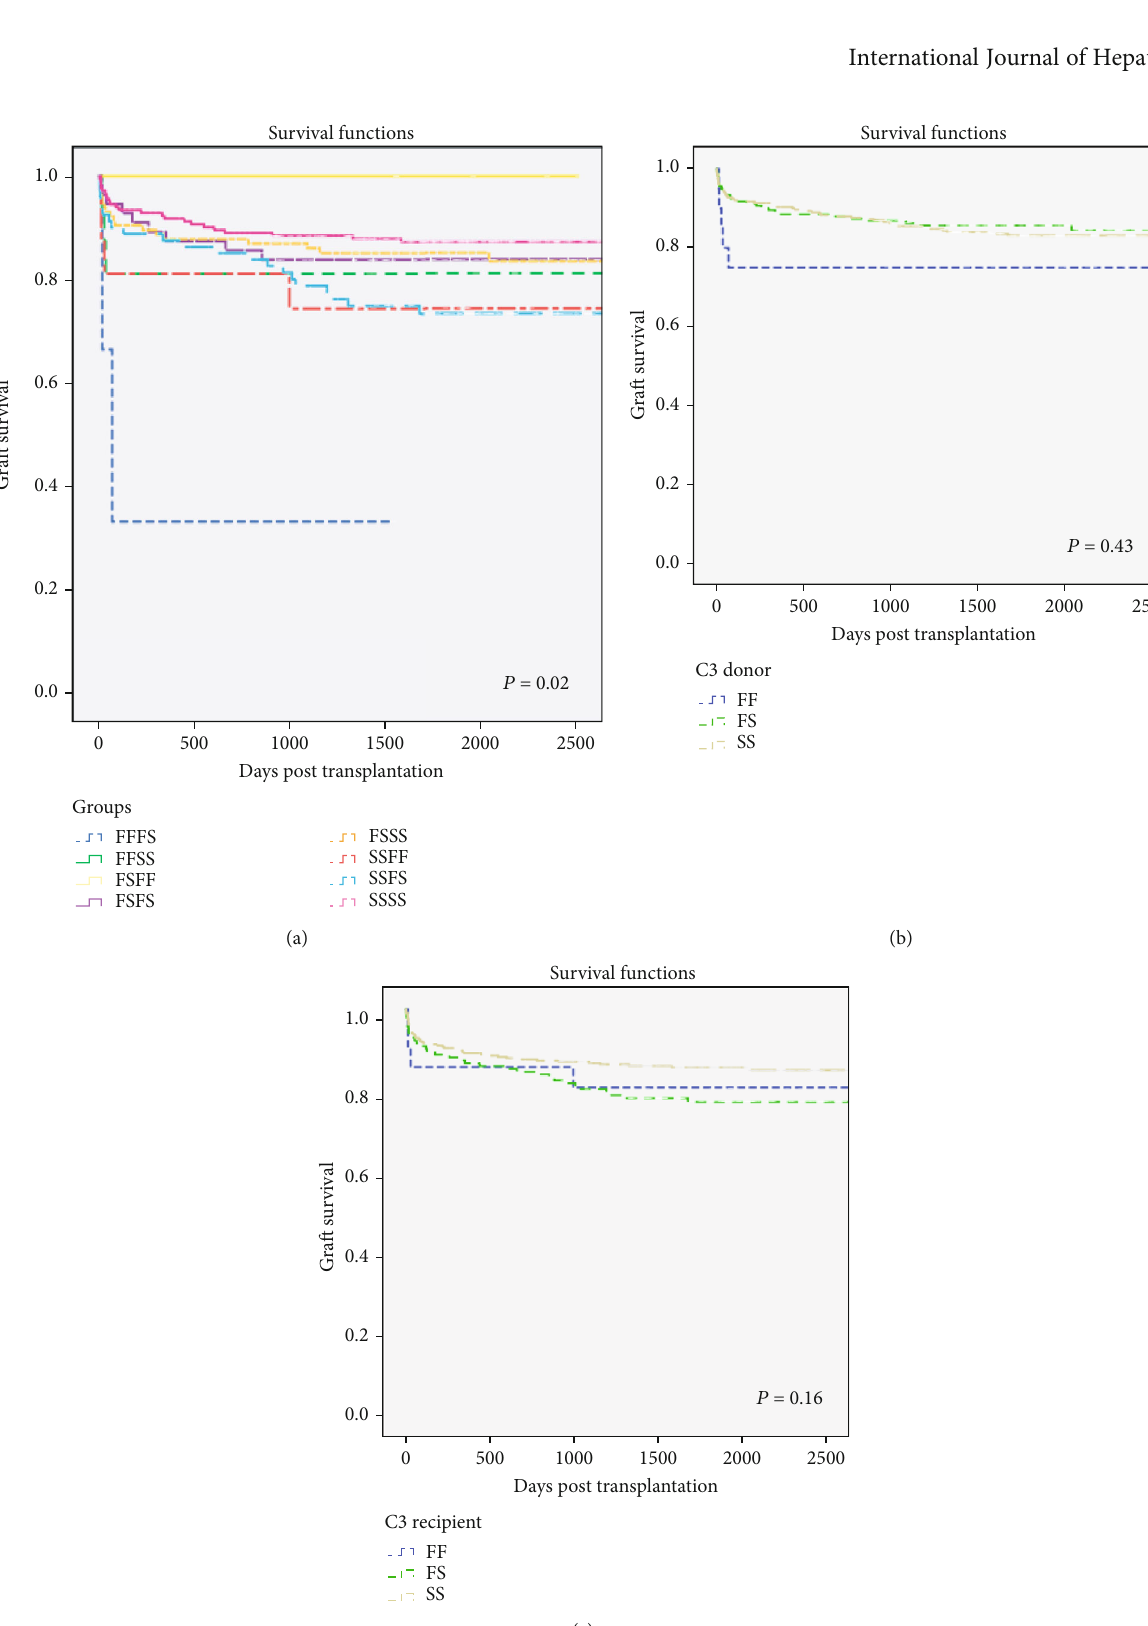
Figure 3: Liver graft survival by donor/recipient complement C3 genotype. Graft survival numbers at risk and log-rank ( P values are shown) up to 2500 days. Paired groups (a) and donor and recipient individual groups (b, c) according to C3 genotype and presence of C3F allele (b, c). P = 0 : 02 for genotype groups. (a) Donor ’ s presence or absence of C3F allele, P = 0 : 43 ; (c) recipient ’ s presence or absence of C3F allele, P = 0 : 16